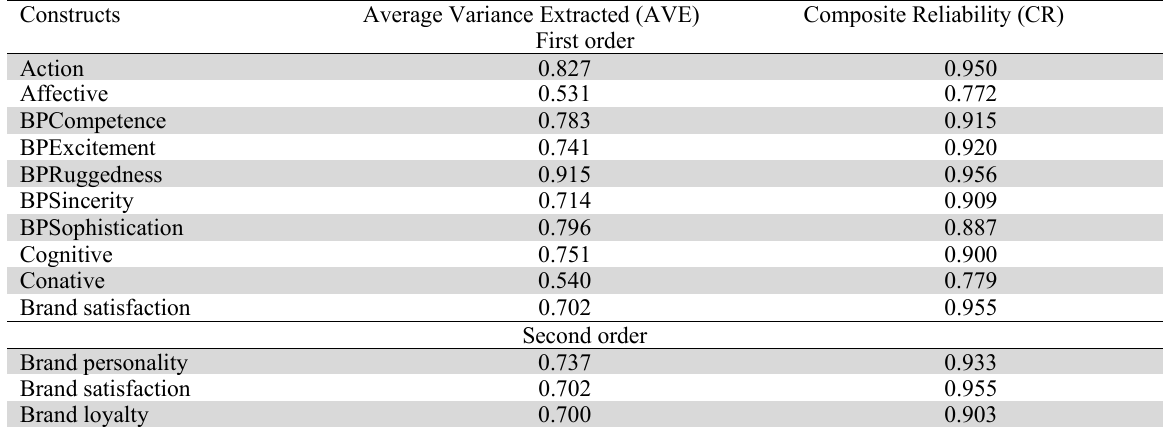
Average Variance Extracted and Composite